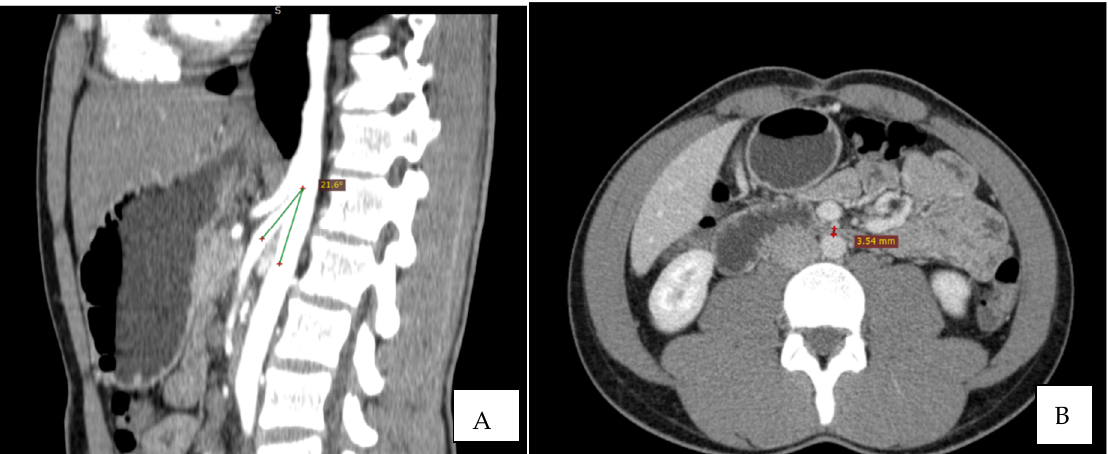
Figure 3. CT: the sagittal reconstruction shows the reduction of aorto-mesenteric angle. (( A ) beak signand distance ( B )).